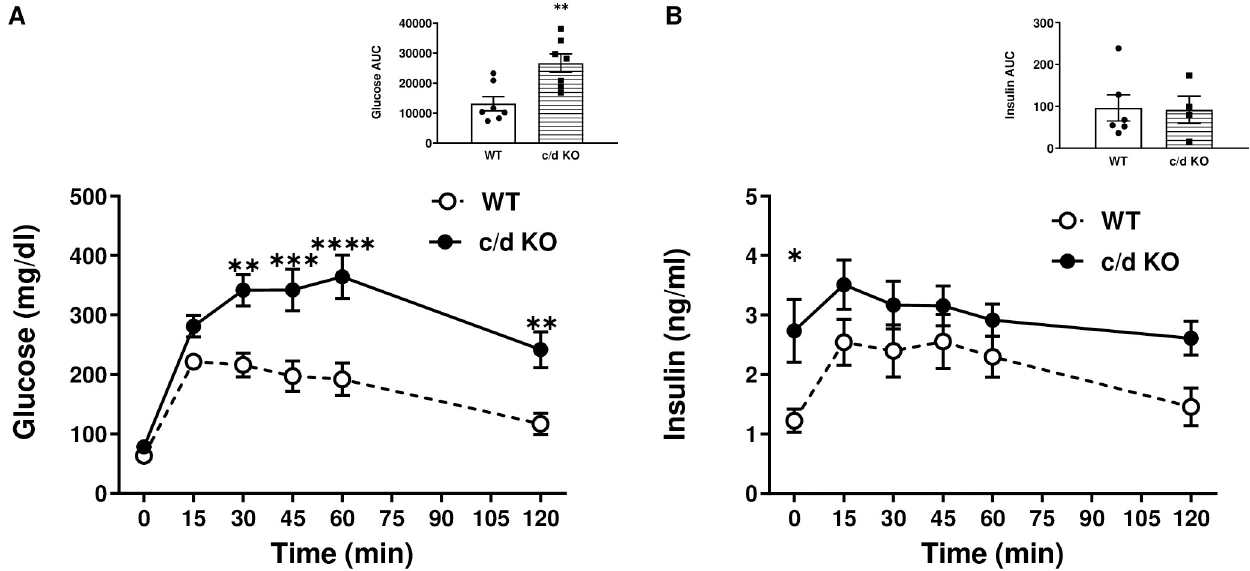
Fig 3. Metabolic consequences of high-fat (HF) diet on miR-181c/d -/- (c/d KO) mice. (A) Blood glucose and area under the curve during an intraperitoneal glucose tolerance test (IPGTT) and ( B) plasma insulin levels and area under the curve during an IPGTT. Data are expressed as mean ± SEM and are from 6–7 mice/genotype/diet. � p < 0.05 by Bonferroni post hoc analysis after intergroup differences were found by 2-way ANOVA. � p < 0.05, �� p < 0.01, ��� p < 0.001, ���� p < 0.0001 by two-sample